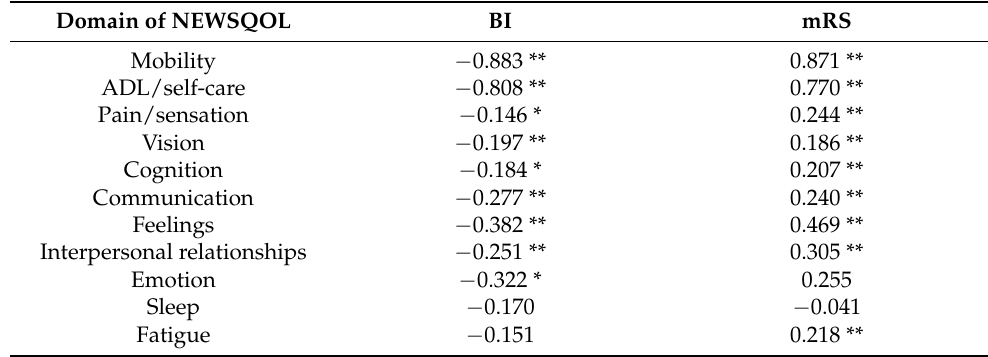
Table 4. Correlation between change scores of studied measures (Spearman’s correlation